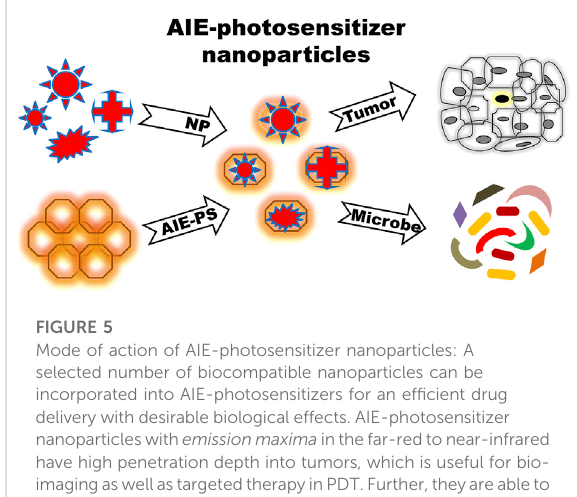
FIGURE 5 Mode of action of AIE-photosensitizer nanoparticles: A selected number of biocompatible nanoparticles can be incorporated into AIE-photosensitizers for an ef fi cient drug delivery with desirable biological effects. AIE-photosensitizer nanoparticleswith emissionmaxima inthefar-redtonear-infrared have high penetration depth into tumors, which is useful for bio- imagingaswellastargetedtherapyinPDT.Further,theyareableto detect speci fi cally and eliminate pathogens from various environment and food sources. Abbreviations: AIE-PS, Aggregation-Induced Emission-Photosensitizer; NP,